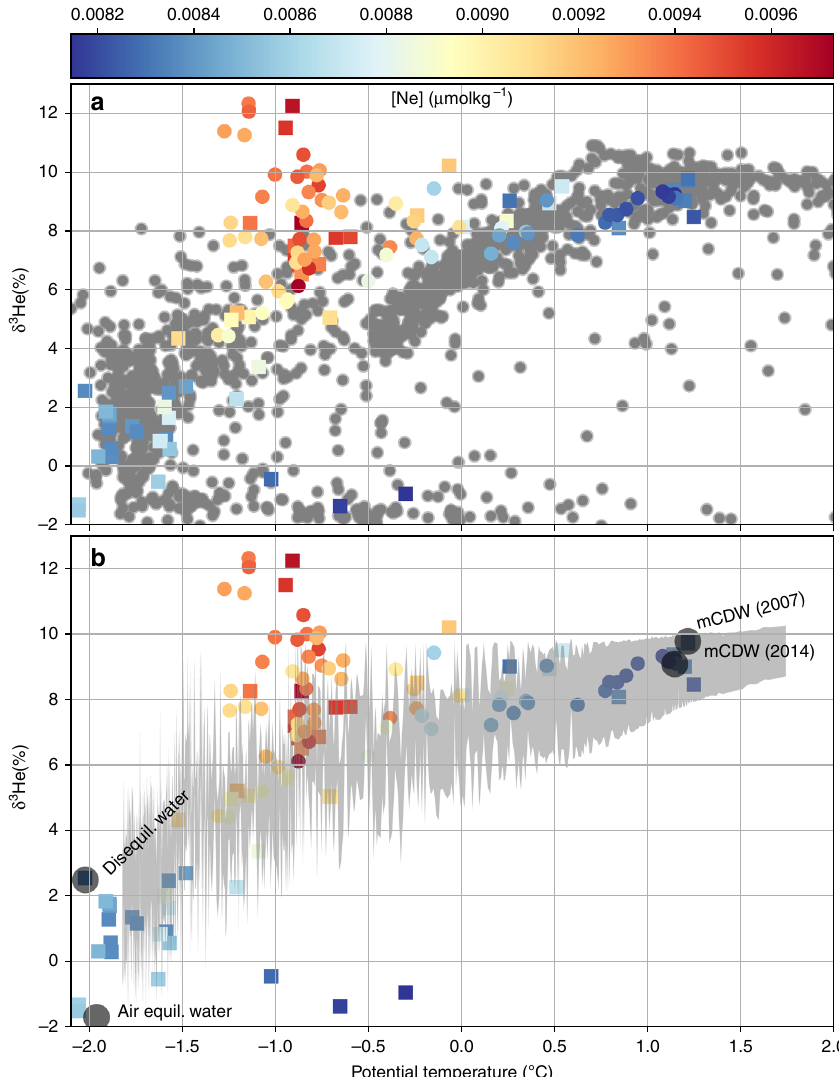
Fig. 2 Distribution of 3 He vs. potential temperature. a The gray circles are values of dissolved δ 3 He vs. seawater potential temperature (°C) from six expeditions to the Paci fi c and Atlantic sectors of the Southern Ocean: NBP00-01, NBP07-02, JR239, I6S, S4P, and JR294 (Ocean2ice), N = 1610. The samples colored by neon concentration are the 106 gas samples collected in Pine Island Bay during NBP07-02 (squares) and JR294 (circles). b The gray shaded area represents the 99% con fi dence region using a bootstrap resampling statistic to reproduce the observed values of δ 3 He from the water mass mixing model that has been constrained by neon, θ and S . In total, 28 of the 106 helium isotope samples exceed the upper con fi dence